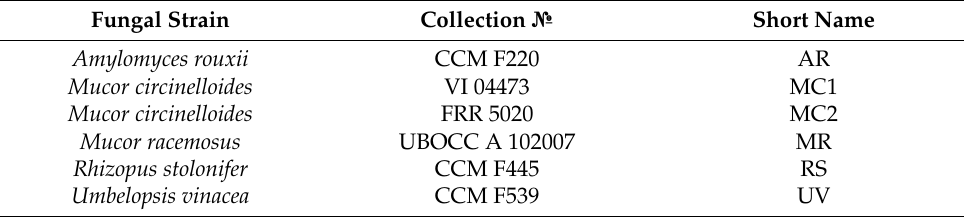
Table 1. Fungal strains used in the study. Fungal